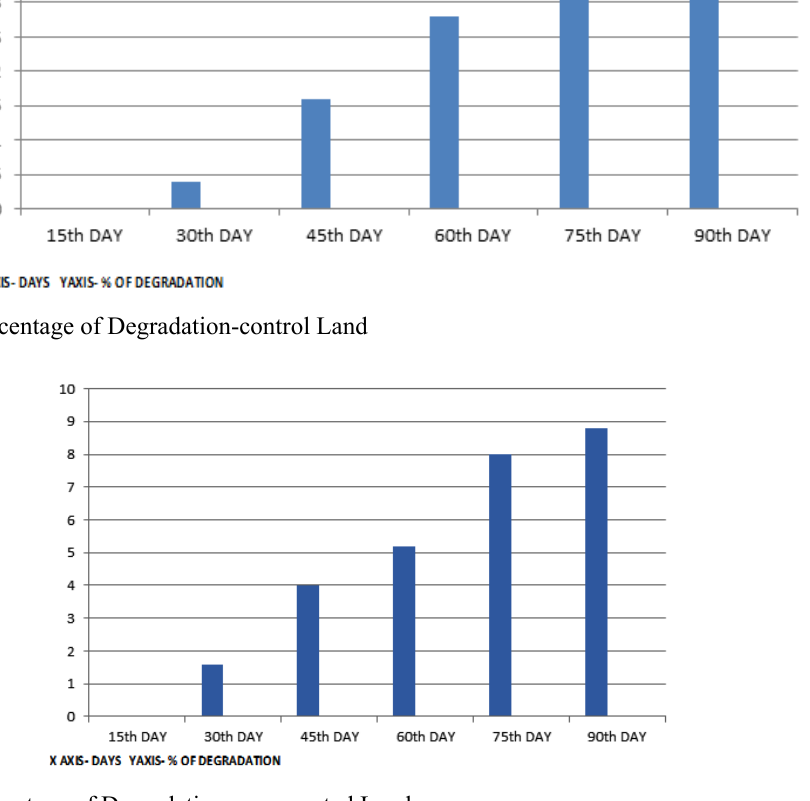
Fig. 2. Percentage of Degradation-augemented